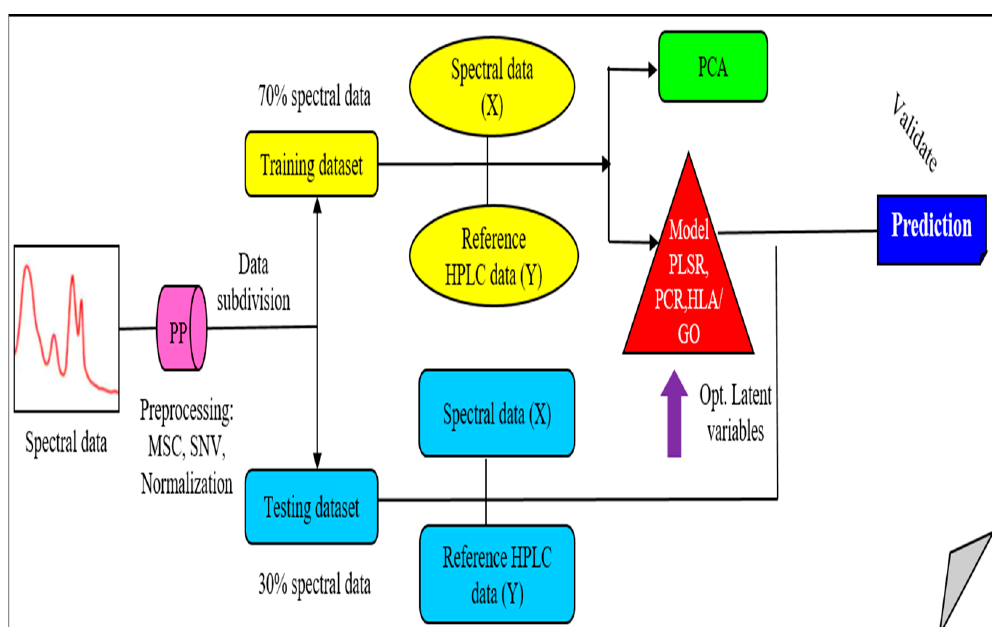
Figure 17. Flowchart for A. thaliana powder samples spectral data analysis.